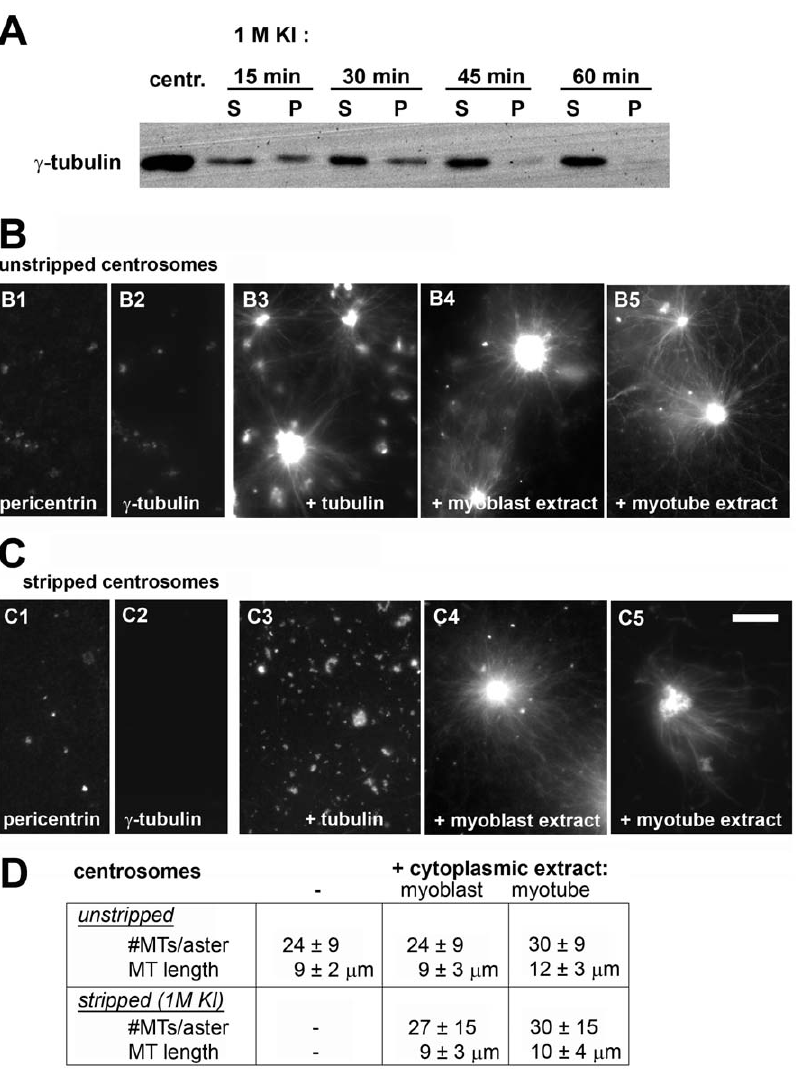
Figure 2. Nucleation of microtubules from salt-stripped centrosomes is restored by cytoplasmic extract of myotubes. (A) Isolated centrosomes from Jurkat cells, treated with 1M potassium iodide (KI) to strip the pericentriolar material. An immunoblot is shown, probed for gamma- tubulin in unstripped centrosomes (centr.), as well as in centrosomes after KI-treatment for 15, 30, 45, and 60 minutes. Treated centrosomes were fractionated by centrifugation, to separate the extracted pericentriolar material (supernatants, S), and the insoluble centrioles (pellets, P). (B) Purified centrosomes, centrifuged onto glass coverslips and stained for immunofluorescence of pericentrin (B1) and gamma-tubulin (B2). Centrosomes were incubated with purified tubulin at 5 mg/ml for 10 minutes, either directly (B3), or following incubation with cytoplasmic extract from undifferentiated myoblasts (B4) or from myotubes (B5). (C) Equivalent experiments as in (B), using centrosomes that had been stripped with KI for one hour. (D) The number of microtubules/aster in a focal plane, as well as the average microtubule length were quantified in each case (n $ 34). Bar in (C), 10 m